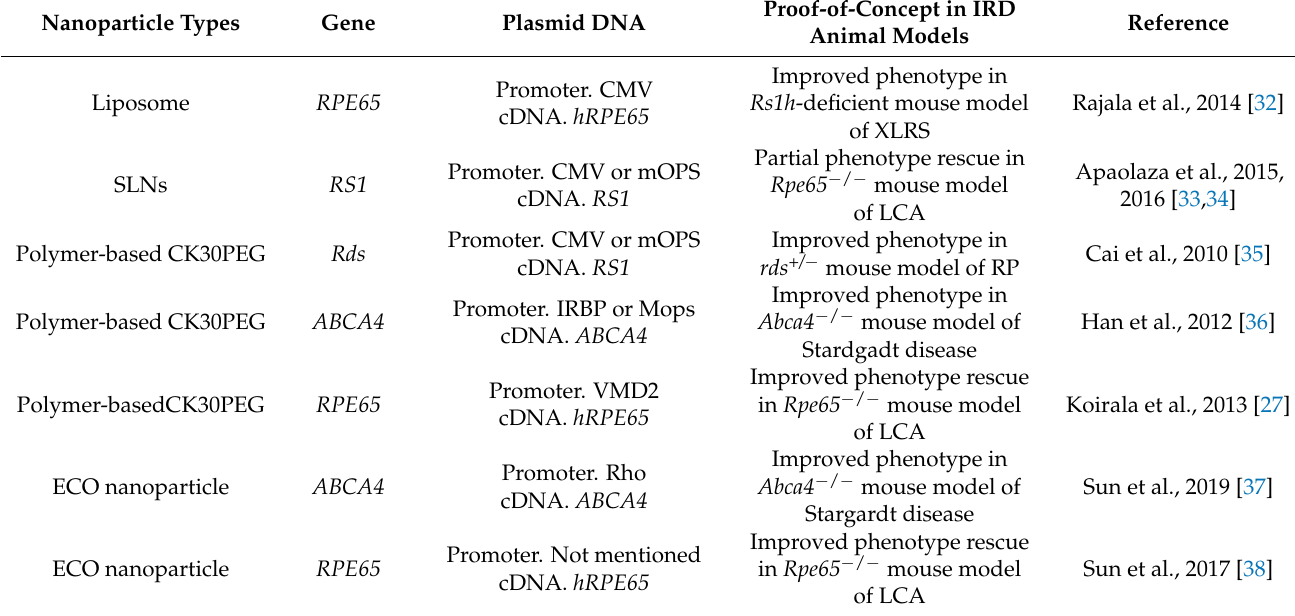
Figure 2. Key nanoparticles of interest for retinal non-viral gene therapy. Several chemical vehicles have been developed as plasmid DNA carriers, such as nanoparticles based on liposomes, solid lipids, niosomes, polymers, and lipopeptide (Created with BioRender.com (accessed on 1 February 2021)). Table 1. Non-viral retinal gene therapy studies in IRD animal